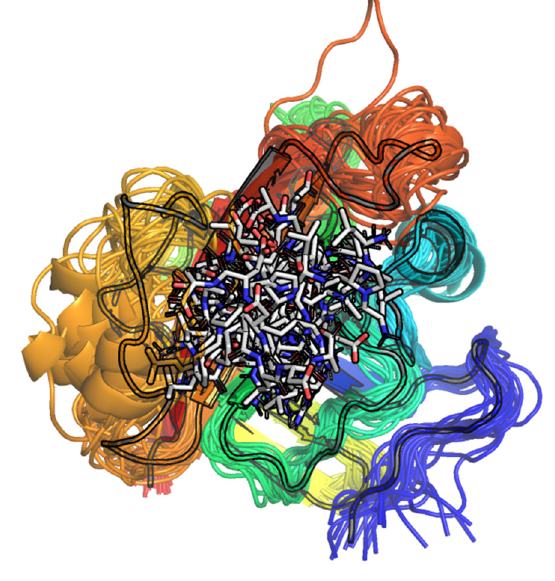
Figure 6. The resulting binding modes are different and occupy generally the entire binding site surface of SrtA. The same view as in Figure 4 is